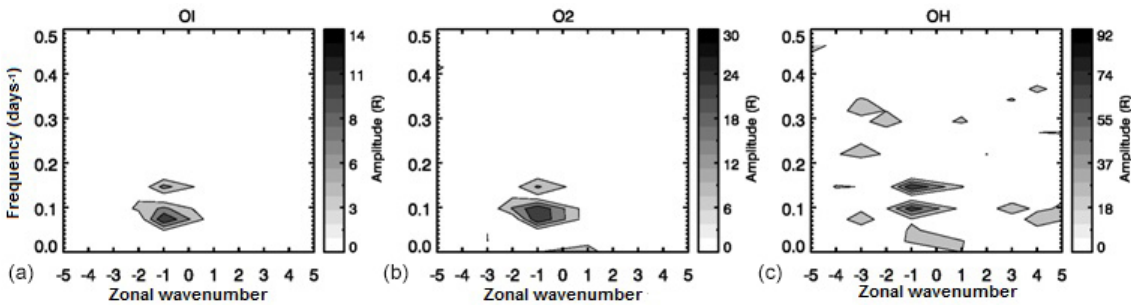
Figure 3. Space–time spectra of the OI5577 (a) , O 2 b (0–1) (b) , and OH(6–2) (c) emissions at 43 ◦ N.